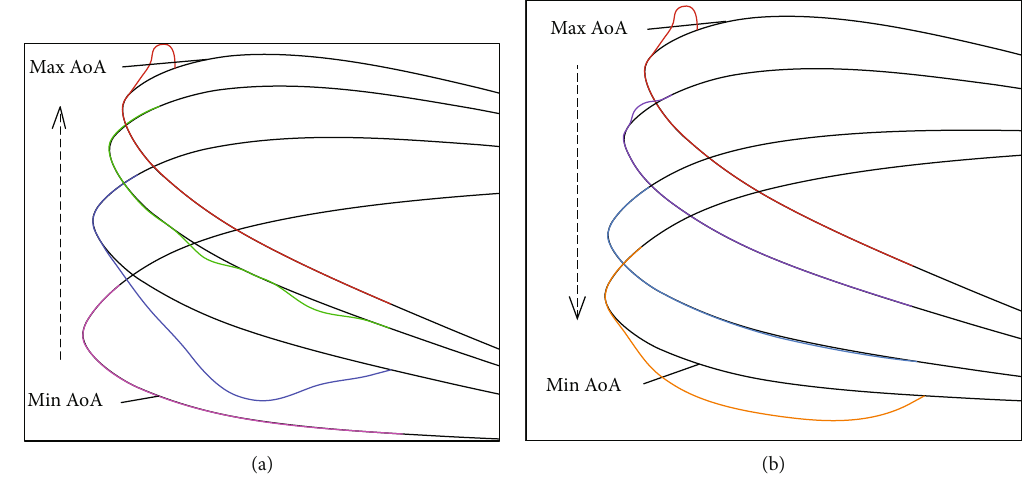
Figure 2: Wrinkling on the elastic membrane during a pitching